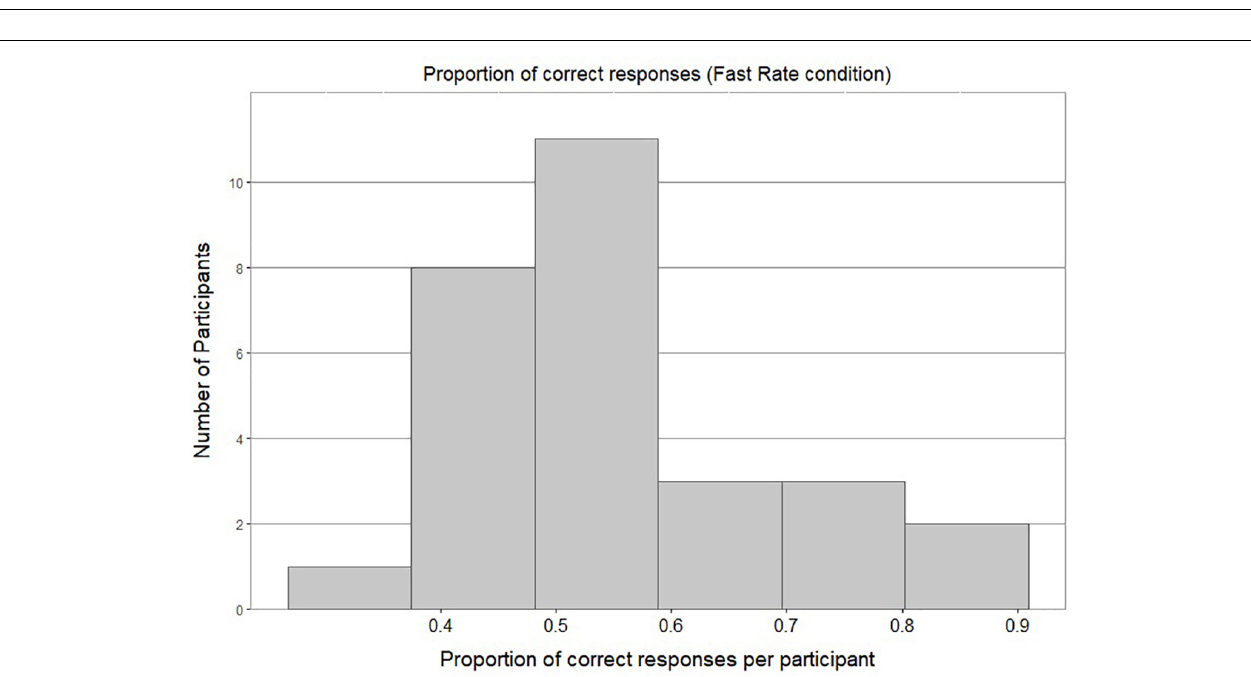
FIGURE 4 | Histogram of proportion of correct responses per participant in Slow Rate Condition.